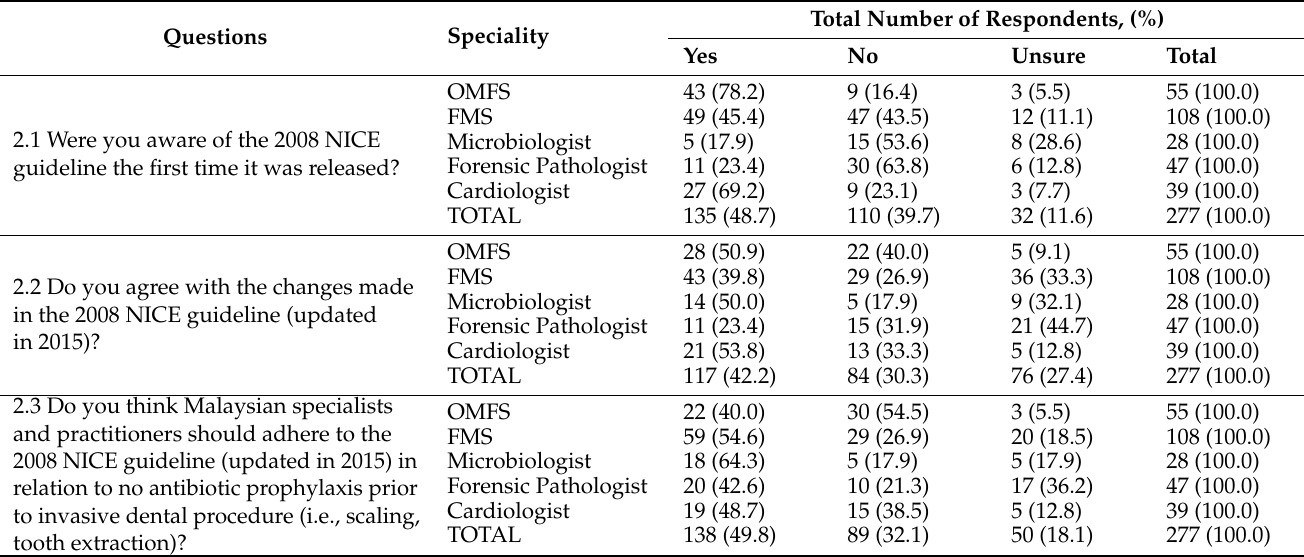
Table 3. Awareness and adherence to the 2008 NICE guideline (updated in